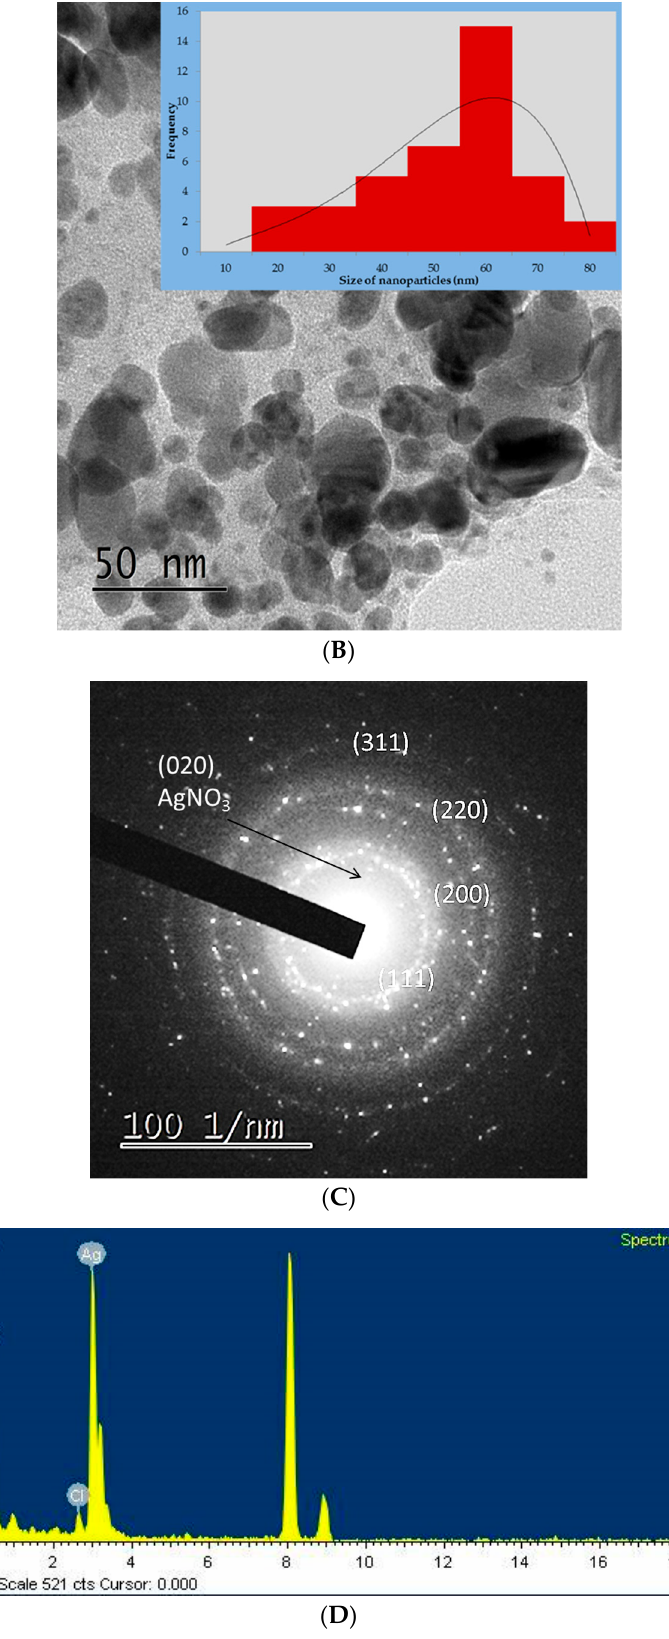
Figure 2. ( A ) SEM image at 500 nm resolution; ( B ) TEM image of DSAgNPs at 50 nm resolution (inset: histogram showing the particle size distribution); ( C ) SAED patern of DSAgNPs; ( D ) EDX spectra of DSAgNPs.